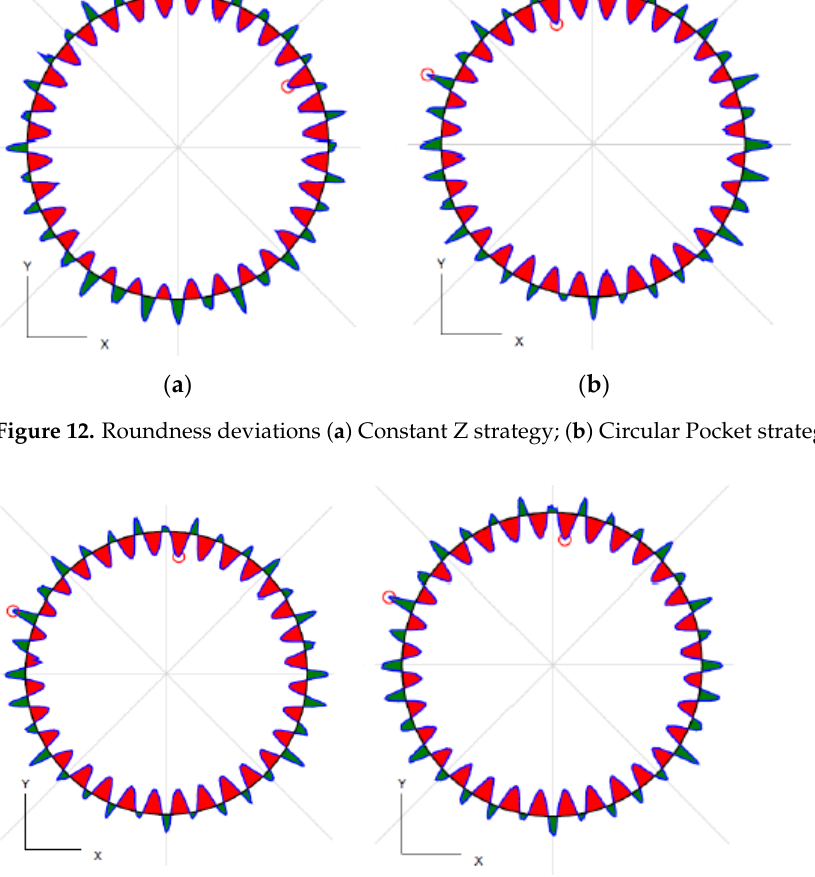
Table 3. Measured roundness deviations.